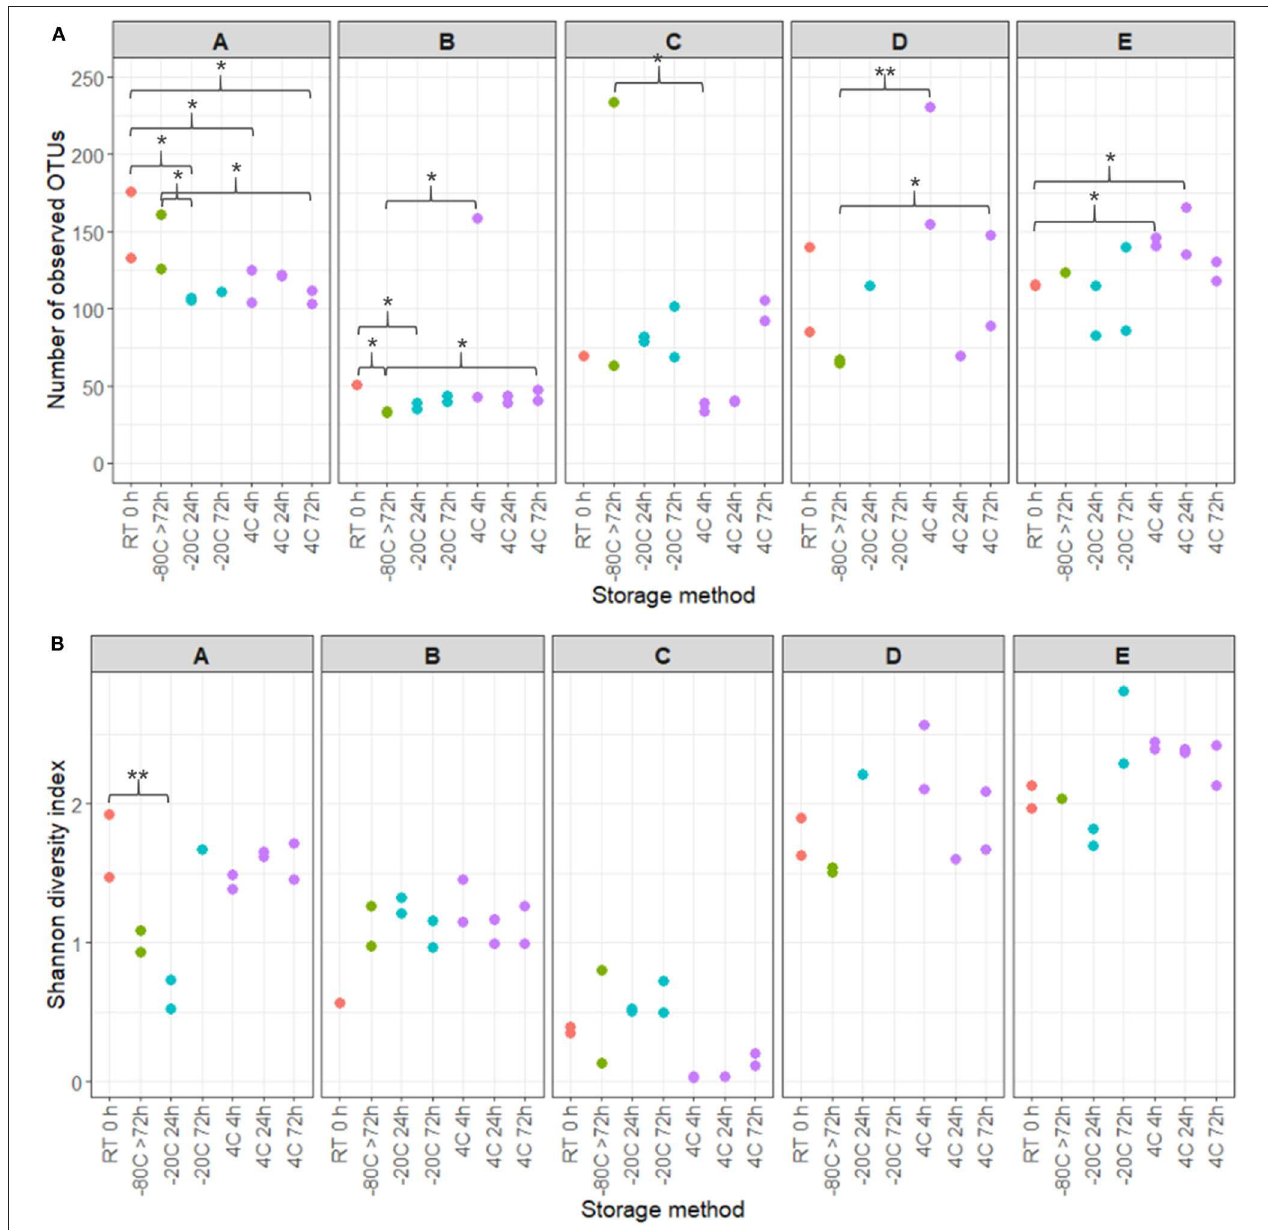
FIGURE 4 | Effects of storage temperature and duration on voided urinary microbiota alpha diversity. (A) OTU richness showing numbers of unique OTUs observed in different storage conditions and durations. (B) Shannon Diversity Index visualizing differences and similarities in diversity of OTU composition within samples. Colors specify differing storage temperatures. Stars indicates statistics compared to RT and − 80 ◦ C samples, with * p < 0.05, ** p <